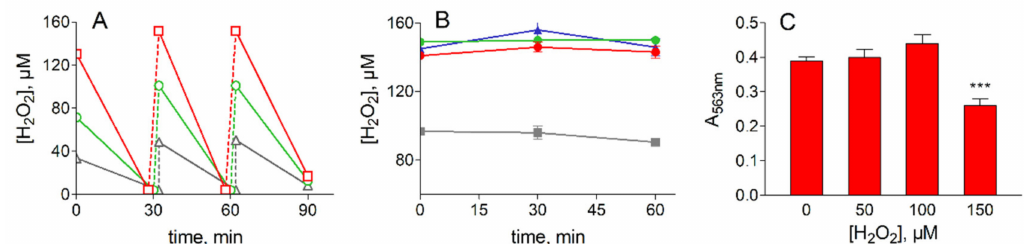
Figure 1. Treatment of ADF cells with H 2 O 2 . ( A ): removal of H 2 O 2 . ADF cells at 70% confluence (2.2 × 10 6 cells) were incubated in Hank’s balanced salt solution (HBSS) (7 mL) at 37 ◦ C; cells were supplemented with 50 (gray), 100 (green) or 150 (red) µ M H 2 O 2 at the times indicated and the concentration of the peroxide was measured as described in Section 2.4. ( B ): Stability of H 2 O 2 in the free-cell medium. H 2 O 2 at the concentration of 100 µ M (gray squares) or 150 µ M (red circles) was incubated at 37 ◦ C in a fresh HBSS medium. Blue squares and green circles refer to the incubation of 150 µ M H 2 O 2 in cell free HBSS medium previously maintained for 60 min at 37 ◦ C in the presence of ADF cells alone or supplemented with 100 µ M H 2 O 2, respectively. ( C ): Viability assay for ADF cells subjected to oxidative insult by H 2 O 2 treatment. 1-(4,5-Dimethylthiazol-2-yl)-3,5-diphenylformazan (MTT) assay was performed at the end of the incubation in the presence of the indicated H 2 O 2 concentrations under the conditions described in Panel ( A ). All the values are the mean ± SEM of at least three independent experiments. Significance was evaluated with respect to untreated cells; *** p <